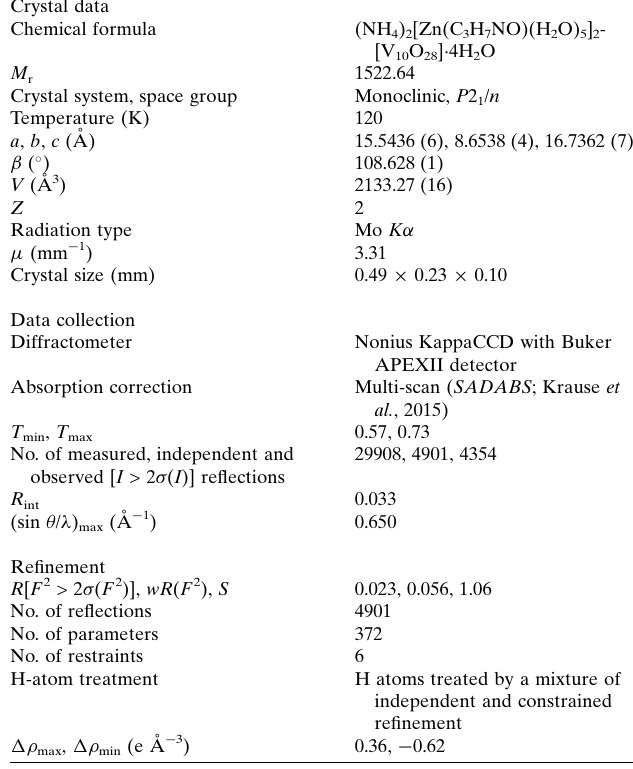
Crystal data Chemical formula